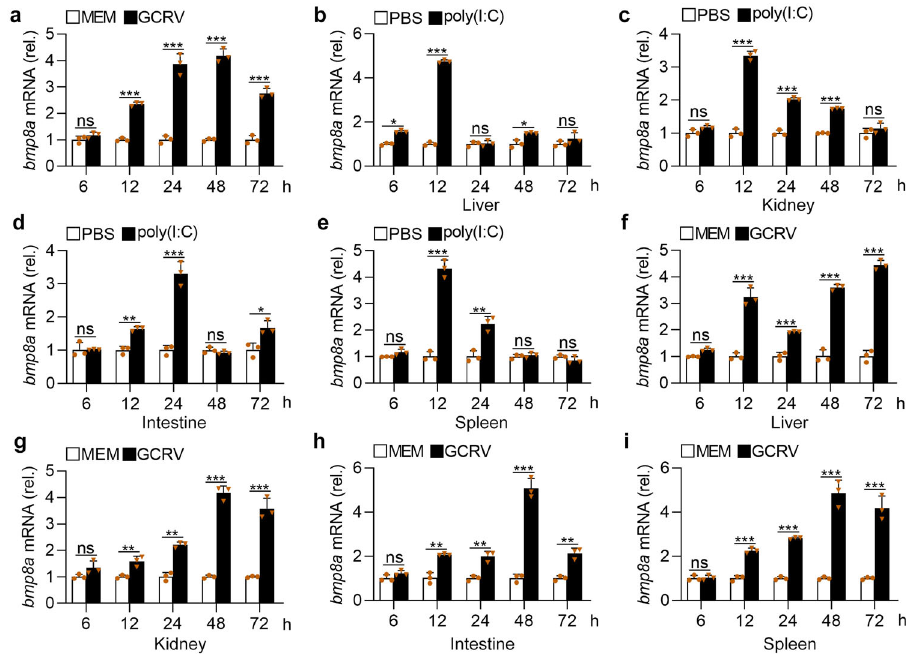
Fig. 7 GCRV or poly(I:C) increases the expression of bmp8a . a Expression of bmp8a mRNA in ZFL cells after infected with GCRV (5 × 10 4 TCID 50 per ml). b – e Expression of bmp8a mRNA in the liver ( b ), spleen ( c ), intestine ( d ), and kidney ( e ) from zebra fi sh injected i.p. with poly(I:C) (10 μ g/ fi sh). f – i Expression of bmp8a mRNA in the liver ( f ), spleen ( g ), intestine ( h ), and kidney ( i ) from zebra fi sh injected i.p. with 50 µ l of GCRV (10 8 TCID 50 per ml). Zebra fi sh injected i.p. with PBS or MEM were used as the control. The expression of actb1 served as a control for the qRT-PCR. Data were from three independent experiments and were analyzed by Student ’ s t -test (two-tailed). All data were presented as mean ± SD (* p < 0.05, ** p < 0.01, and *** p < 0.001, ns means no signi fi cant